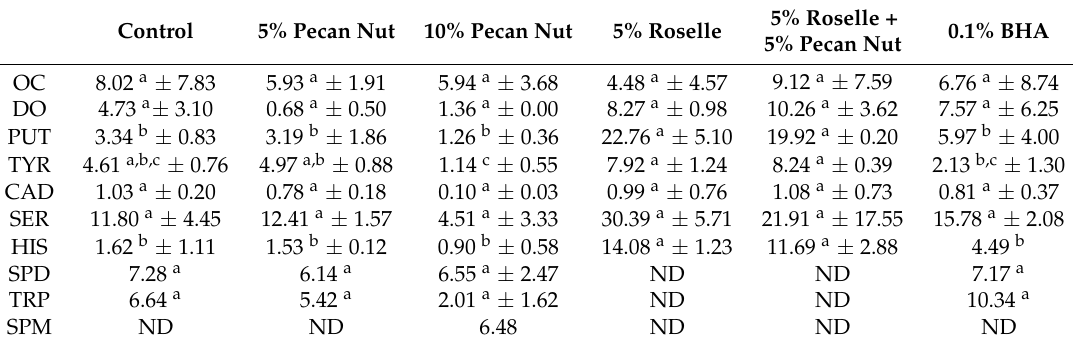
Table 5. Biogenic amines present in Sardina pilchardus meat samples with different treatments at day 5 1